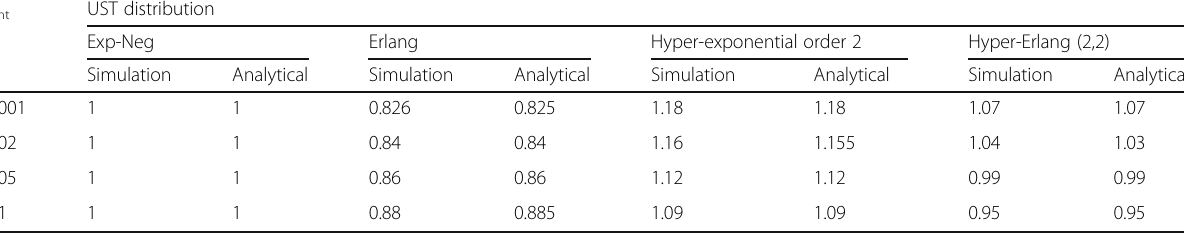
Table 4 Coefficient of variation of the CHTn for different distributions of the UST when CDT is exponentially distributed P Int UST